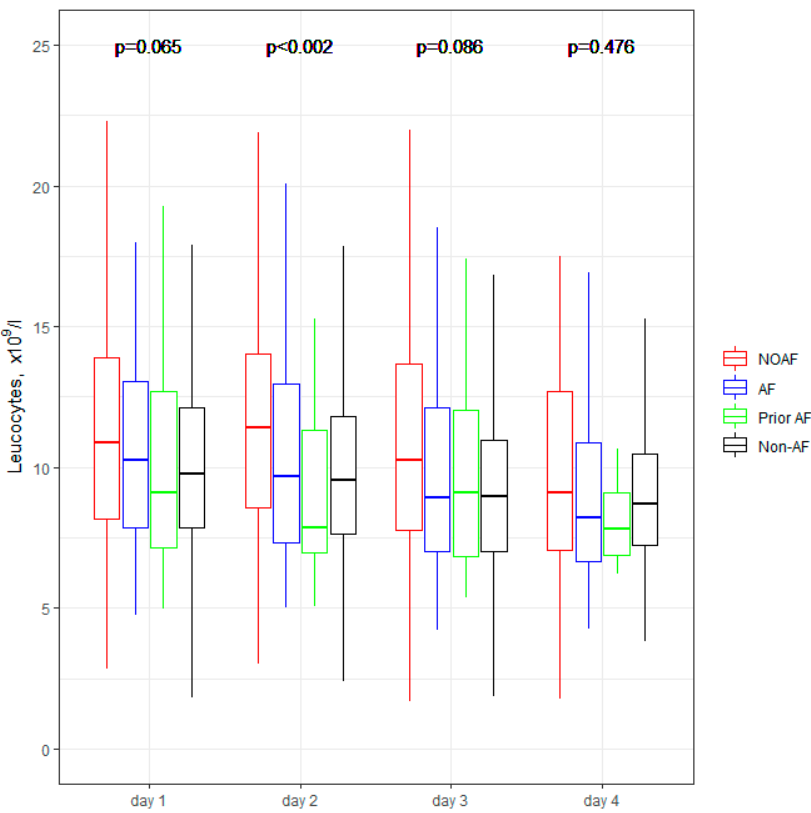
Figure 3. Leucocytes within the first four days of hospitalization. The center represents the median value. The upper and lower quartiles values are displayed with whiskers. p -values on the figure represent the group changes (the Kruskal–Wallis test). The time changes were calculated by the Friedman test and paired samples Wilcoxon test with Bonferroni adjusted ( p < 0.001). NOAF—group of patients with any newly diagnosed AF that appeared during AMI hospitalization; AF—group of patients with a previously documented diagnosis of AF who additionally had AF during AMI hospitalization; Prior AF—group of patients with a previously documented diagnosis of AF who had not developed AF during AMI hospitalization; Non-AF—group of patients with no evidence of AF during AMI hospitalization and without the prior AF diagnosis.